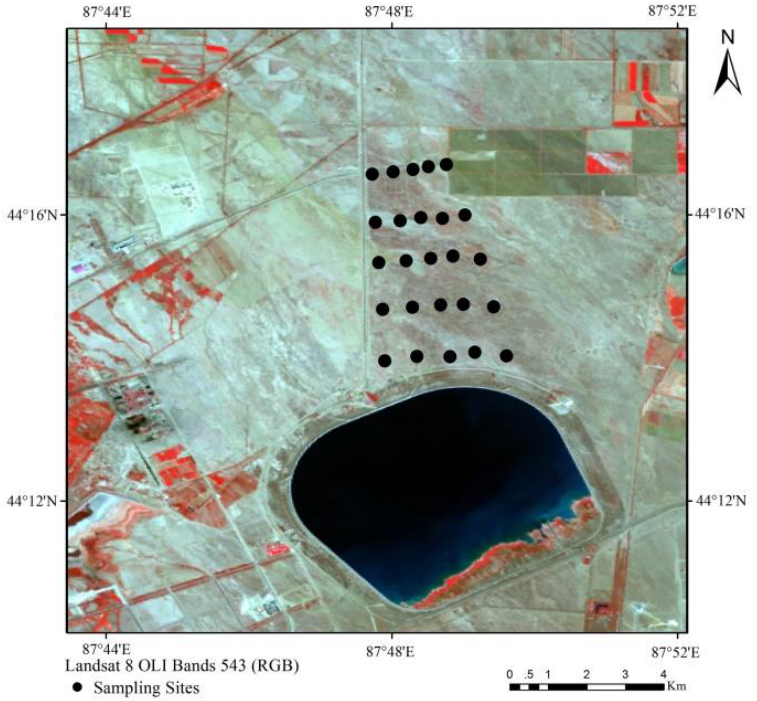
Figure 1. Distribution of sampling points.